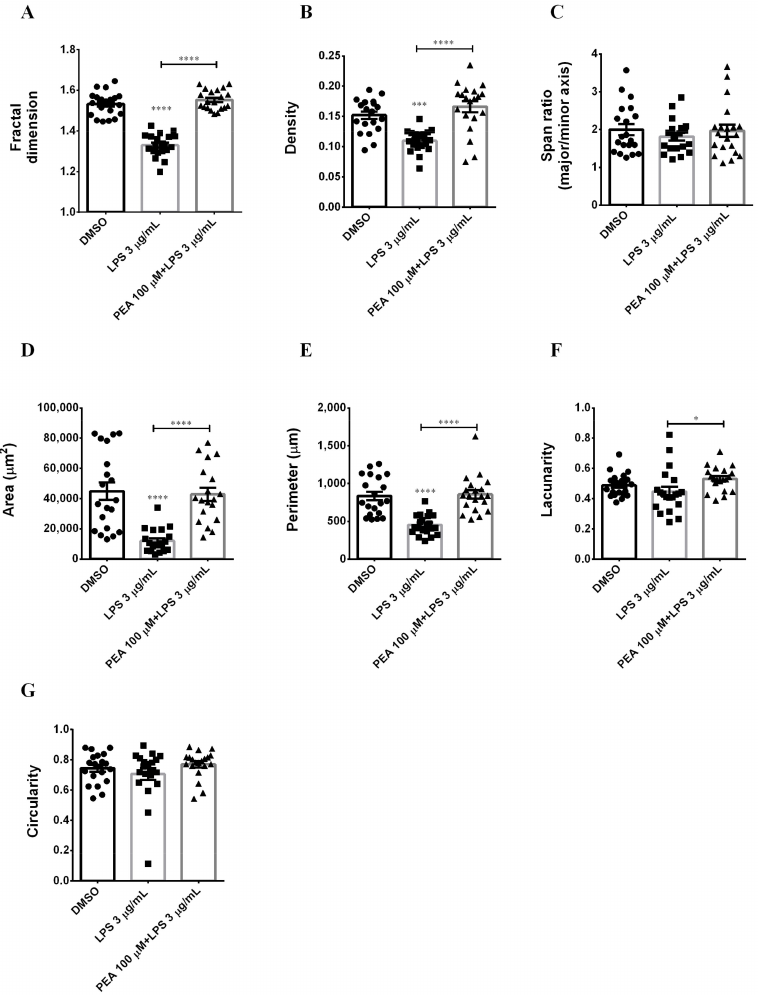
Figure 5. Effect of PEA on microglia complexity, elongation, and size in LPS-stimulated N9 cells. Summary data and statistical analysis of fractal dimension ( A ), density ( B ), span ratio ( C ), area ( D ), perimeter ( E ), lacunarity ( F ), and circularity ( G ). Total number of cells analyzed for each condition n = 20. Data are shown as the mean ± S.E.M. Differences between groups were tested for significance by applying the ANOVA test and Tukey post hoc test. * p < 0.05, *** p < 0.001, **** p <